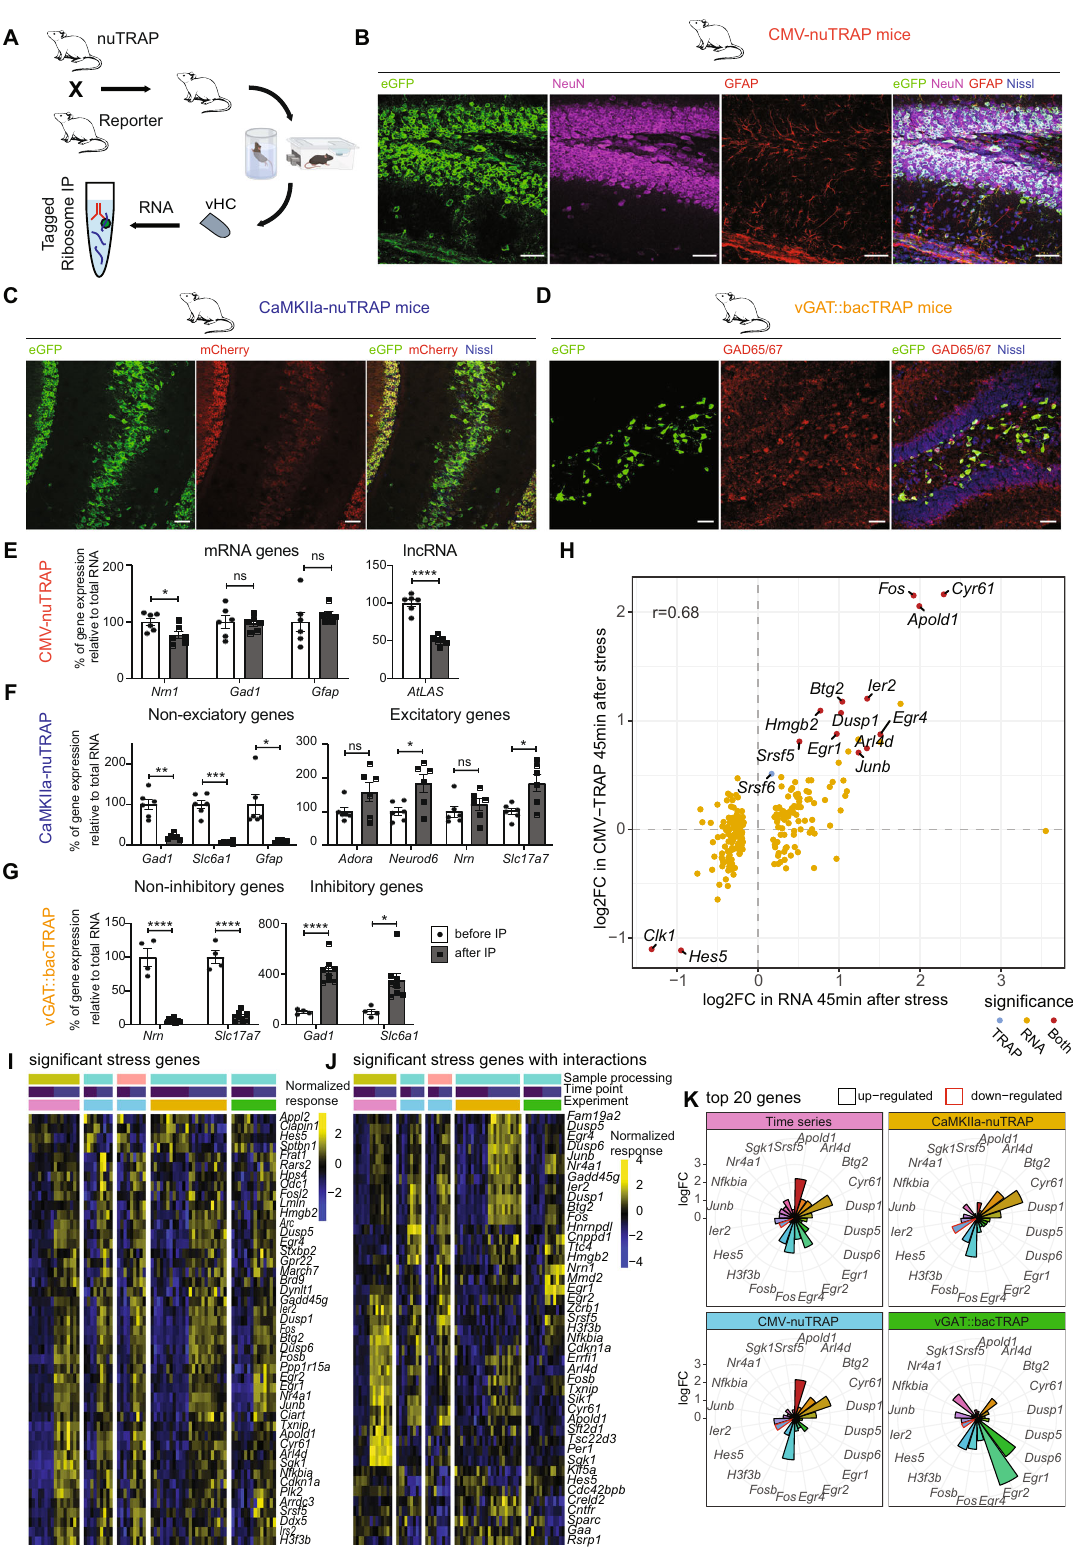
were enriched in the bound RNA fraction of vGAT::bacTRAP inhibitory and excitatory genes in the CaMKIIa-nuTRAP and tissue (Fig. 6G). However, the enrichment of excitatory genes vGAT::bacTRAP samples before IP (total RNA) and afterwards seems to be less ef fi cient in CaMKIIa-nuTRAP samples. This is (bound RNA). As expected, inhibitory and glial genes were likely due to several reasons: (1) excitatory neurons are the depleted, and excitatory genes were largely enriched in the bound majority of neurons in HC, and hence it is harder to show RNA fraction of CaMKIIa-nuTRAP HC samples (Fig. 6F). enrichment of this abundant cell type. (2) These genes might not Conversely, excitatory genes were depleted and inhibitory genes NATURE COMMUNICATIONS| (2022) 13:1824